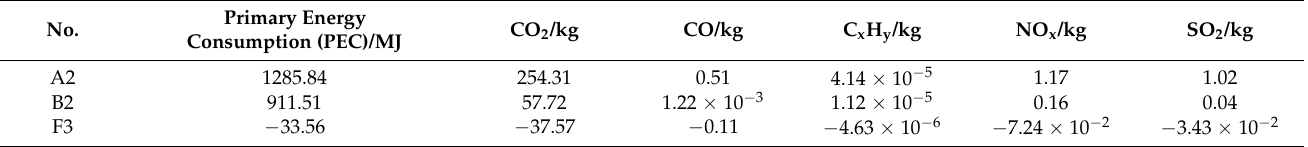
Table 5. LCA data summary of 1 m 3 specimen.